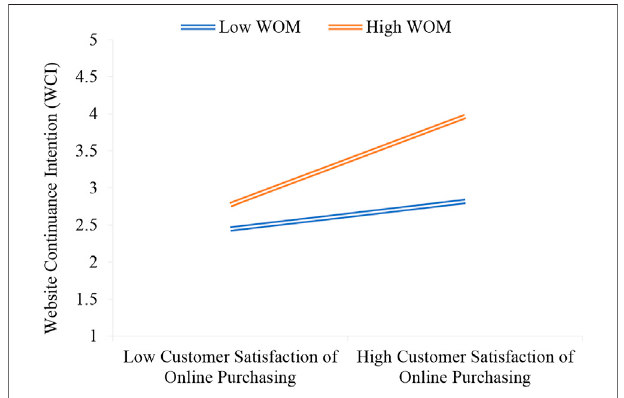
FIGURE2| Interactionplotofcustomersatisfactionofonlinepurchasing x WOM on the website continuance intention (WCI).